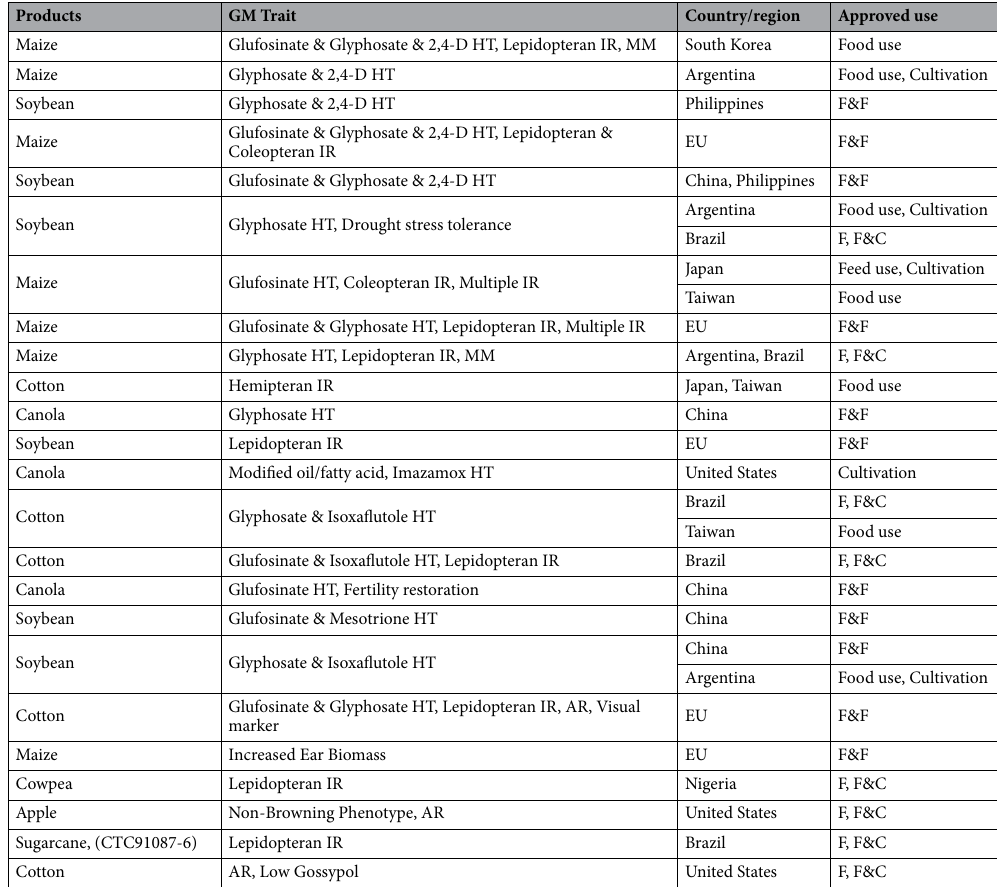
Table 1. New GM product approved in 2019 and the latest update in 2020 34,35 . F & F food and feed use; F, F & C food, feed and cultivation; HT herbicide tolerant; IR insect resistant; MM Mannose metabolism; AR antibiotic